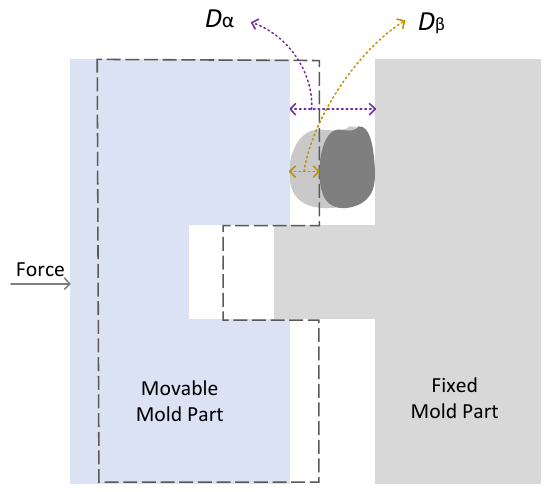
Figure 3. Damage distance and detected